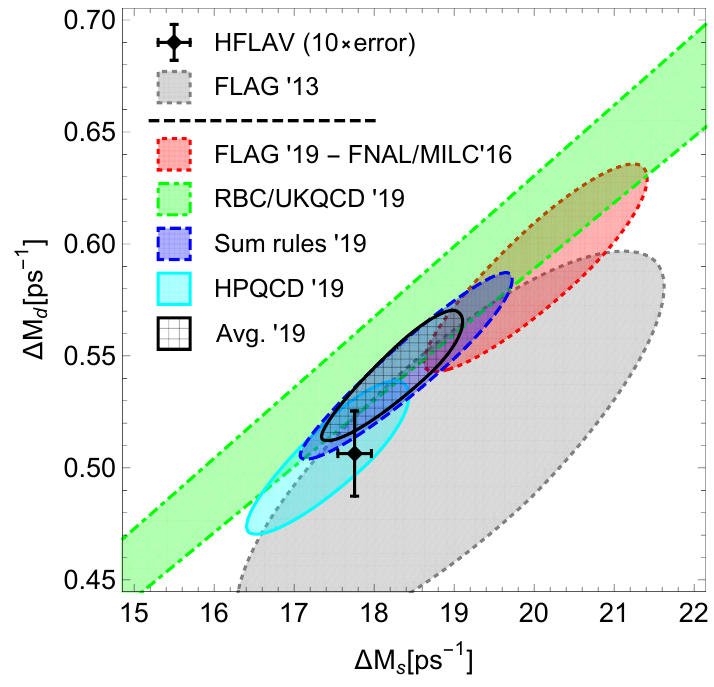
Figure 1 . Predictions for (cid:1) M